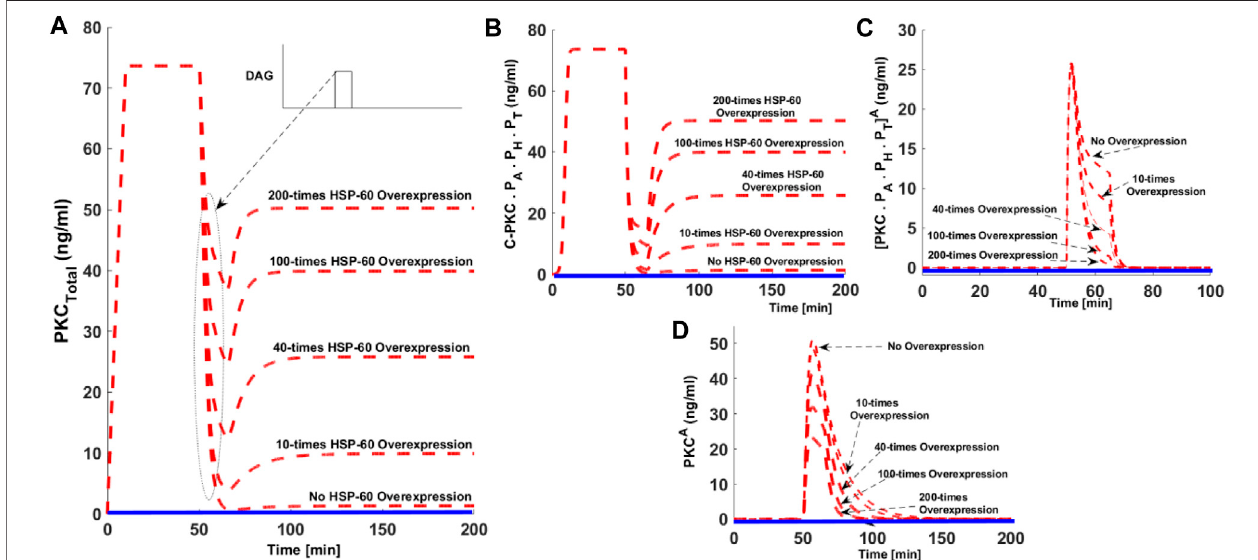
FIGURE 6 | The effect of hsp70 overexpression on the cPKC life cycle. Here, the dashed red line shows stimulated conditions whereas, solid blue line show non- stimulatedconditions. (A) TheconcentrationoftotalPKCenzyme.Here,underthenohsp70overexpressionconditionthestrongsecondmessengerstimulationleadsto the complete down-regulation of cPKC enzyme. Interestingly, when these simulations are run with hsp70 overexpression the degree of down-regulation after second messenger stimulation is reduced in a dose-dependent manner. These results indicate the possible role of hsp70 expression in re-stabilization of active but dephosphorylated PKC enzyme. (B) The concentration of C-PKCP A . P H .P T with no hsp70 overexpression and dose-dependent reversal of C.PKC.P A .P H .P T concentrationwithhsp70overexpression. (C) Theconcentrationof[PKC.PA.PH.PT] A withnohsp70overexpressionanddose-dependentreductionof[PKC.PA.PH.PT] A , concentration with hsp70 overexpression. (D) The concentration of PKC A , with no overexpression and dose-dependent reduction in concentration and time persistence with hsp70 overexpression.